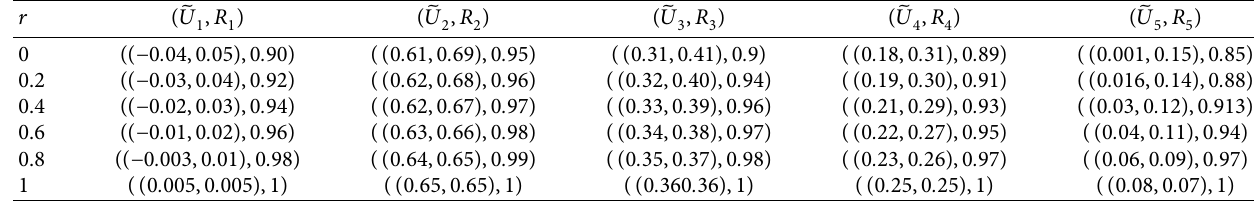
Table 12: Te diferent values of [ U ] Z for λ � 0 . 05 and r � 0 , 0 . 1 , ... ,